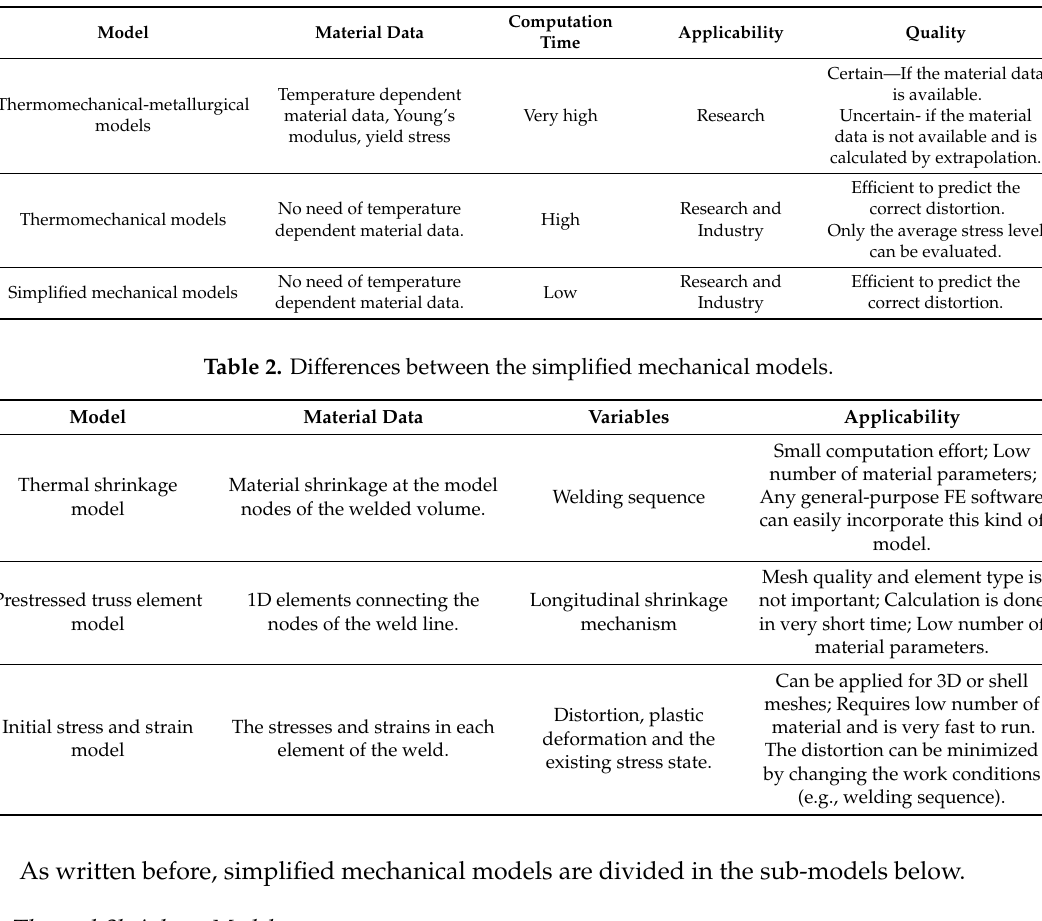
Table 1. Comparison between models [6].